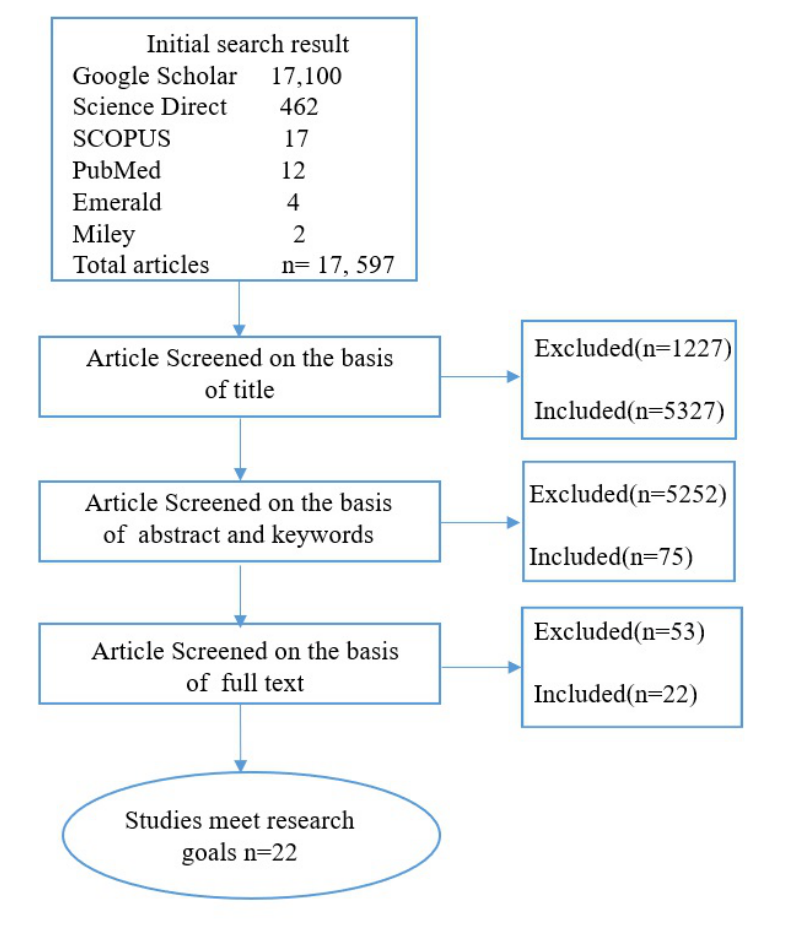
Figure 2. Research